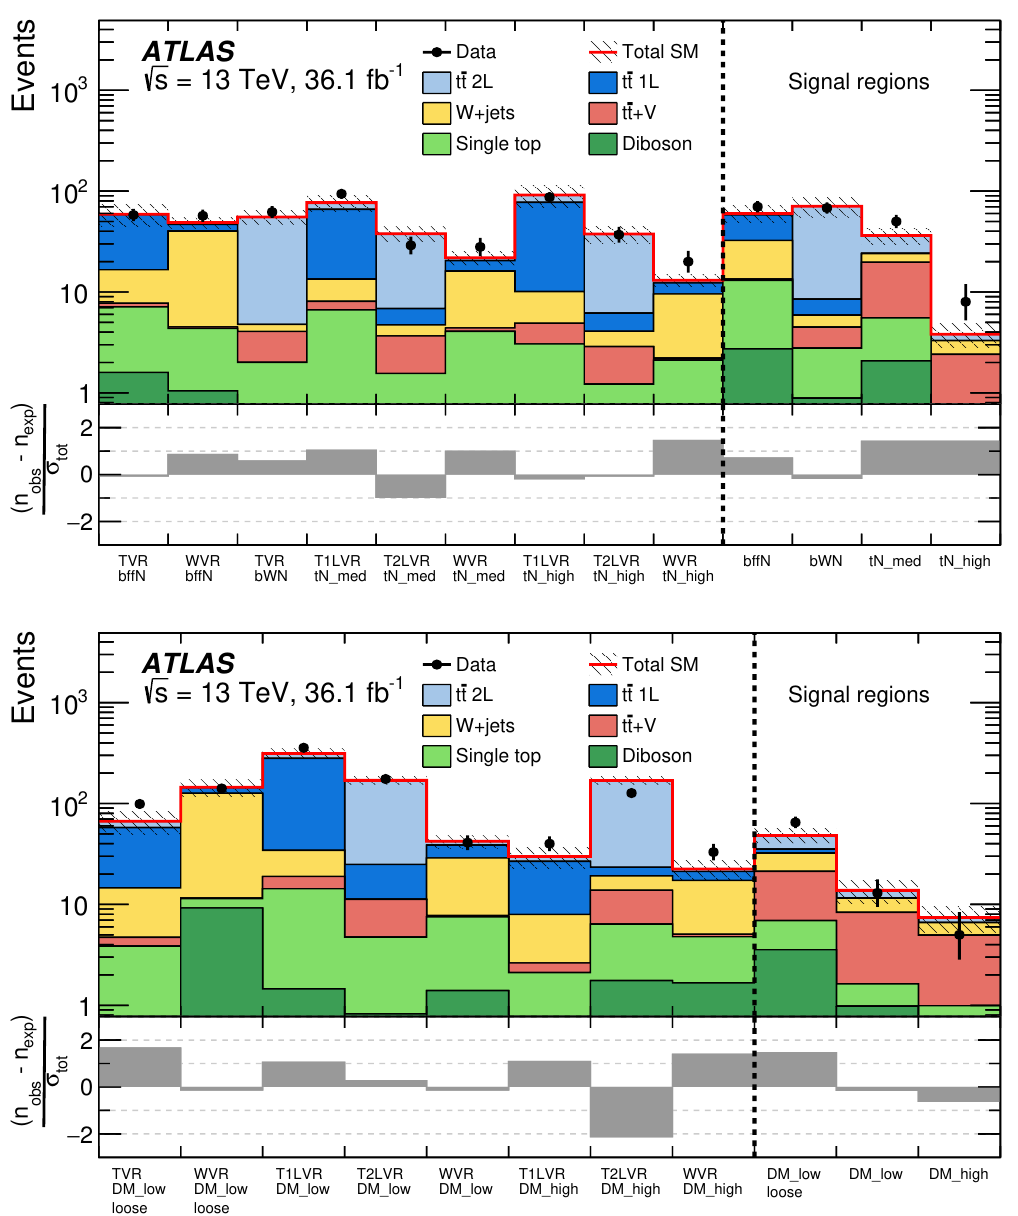
Figure 15 . Comparison of the observed data ( n obs ) with the predicted SM background ( n exp ) in (top) the bffN , bWN , tN med and tN high signal regions, and (bottom) the DM low loose , DM low , and DM high signal regions, and associated VRs. The background predictions are obtained using the background-only (cid:12)t con(cid:12)guration, and the hatched area around the SM prediction includes all uncertainties. The bottom panels show the di(cid:11)erence between data and the predicted SM background divided by the total uncertainty ( (cid:27) tot